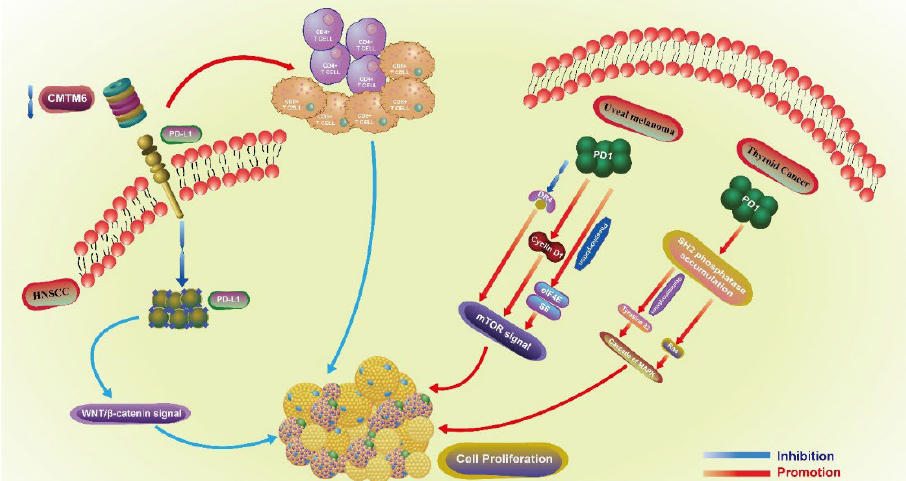
Figure 2. The proliferative role of PD1 in uveal melanoma and thyroid cancer, PD-L1 in HNSCC. Proliferative regulation-related pathways of PD1 involved in uveal melanoma and thyroid cancer, PD-L1 in HNSCC. Different immune checkpoints play a role in the regulation of proliferation through different signaling pathways and other molecular mechanisms in different tumors. HNSCC: head and neck squamous cell carcinoma.